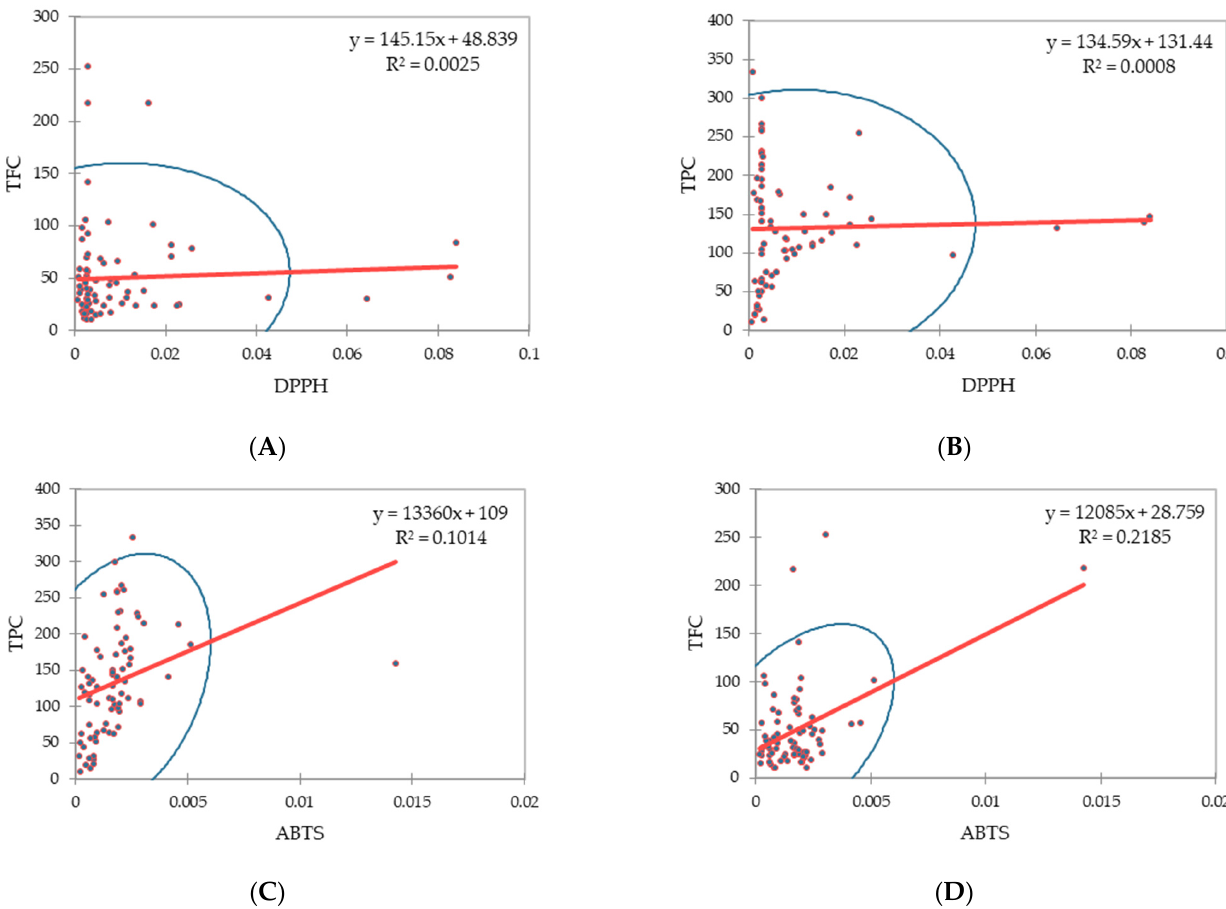
Figure 2. Correlation coefficients between the ( A ) DPPH and total flavonoid content, ( B ) DPPH and total phenolic content, ( C ) ABTS and total phenolic content, and ( D ) ABTS and total flavonoid content in selected S. bicolor accessions.